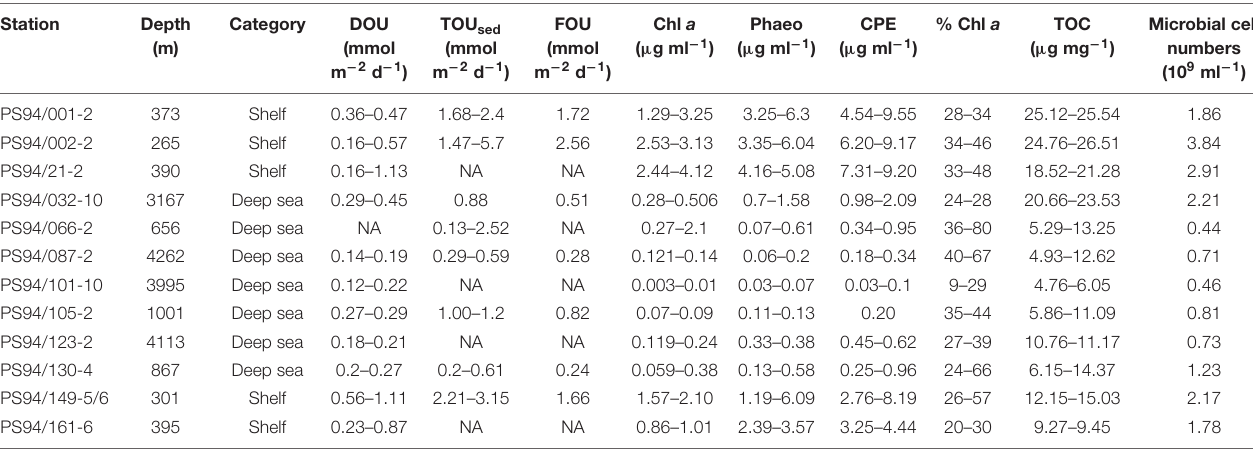
FIGURE 1 | Map of stations sampled for this study (PS94) and comparative datasets from two previous surveys from the Laptev and Beaufort seas. (A) Stations sampled for this study during RV Polarstern expedition PS94 in 2015 (stations on the map indicated by stars), (B) stations sampled in the Beaufort Sea in 2008 and 2009 (stations indicated by squares), and (C) stations sampled in the Laptev Sea during RV Polarstern expedition PS80 in 2012 (stations indicated by circles). The underlying bathymetric chart was provided by Jakobsson et al. (2012). TABLE 2 | Range of all parameters assessed during PS94